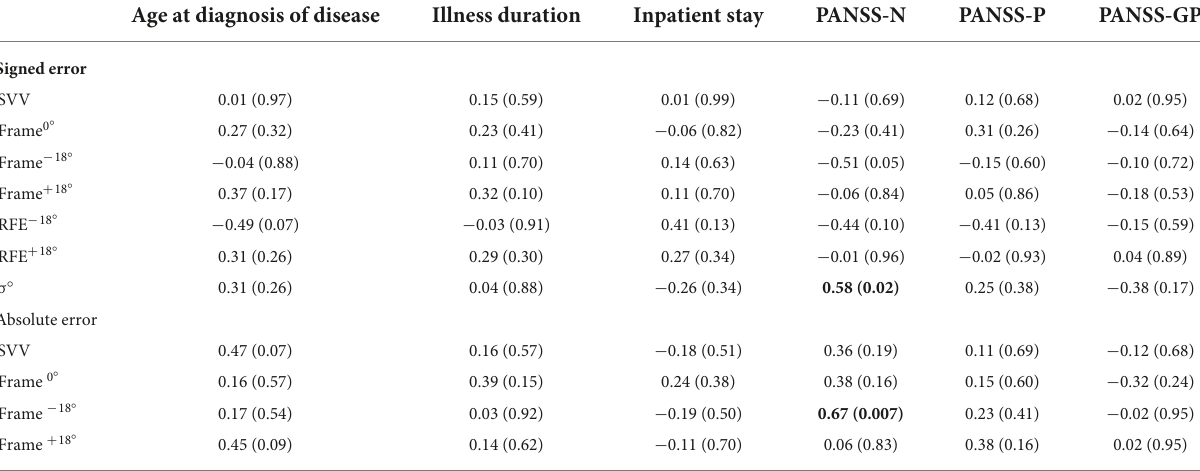
TABLE 3 Correlation between SCZ clinical measures, psychotic symptoms severity and deviation errors or derived measures on the RFT. Age at diagnosis of